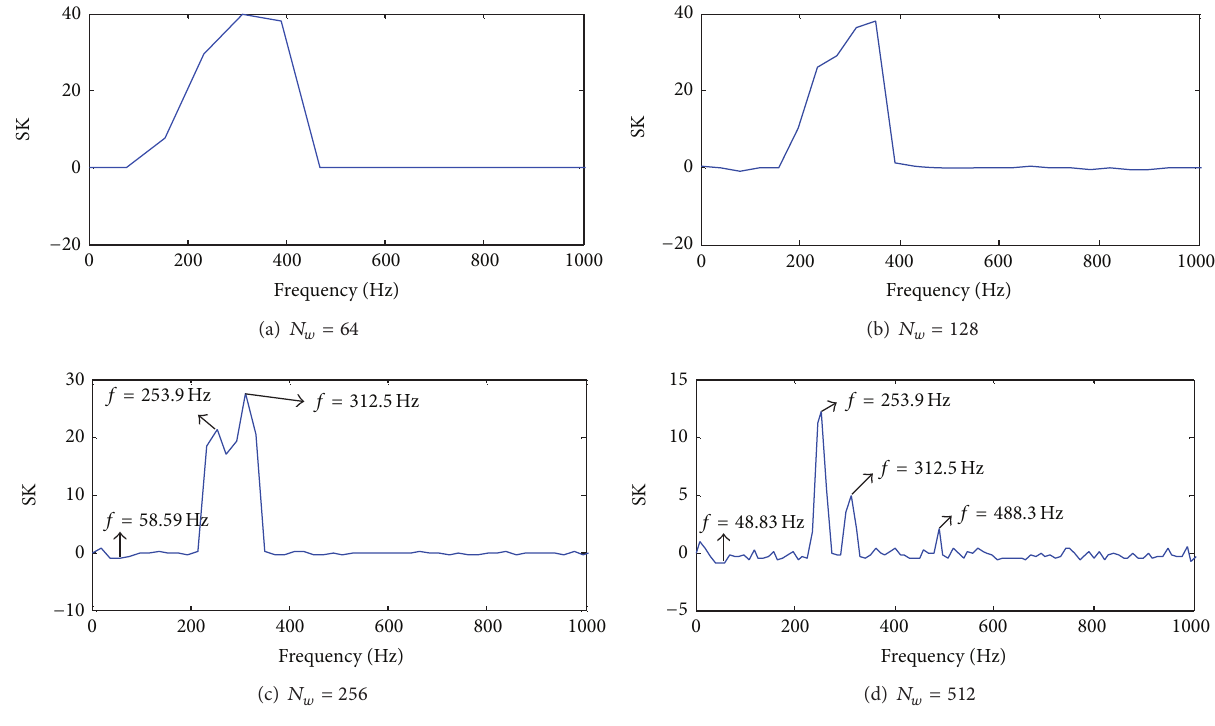
Figure 2: Length of window